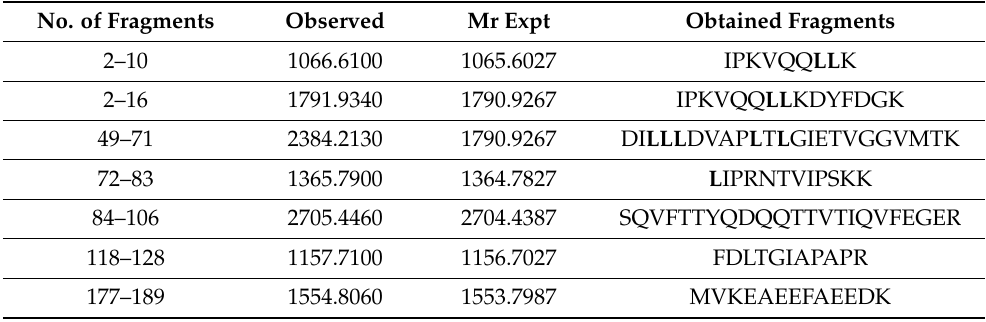
Table 2. Obtained peptide fragments of Solanum trilobatum antibacterial protein indicates the leucine